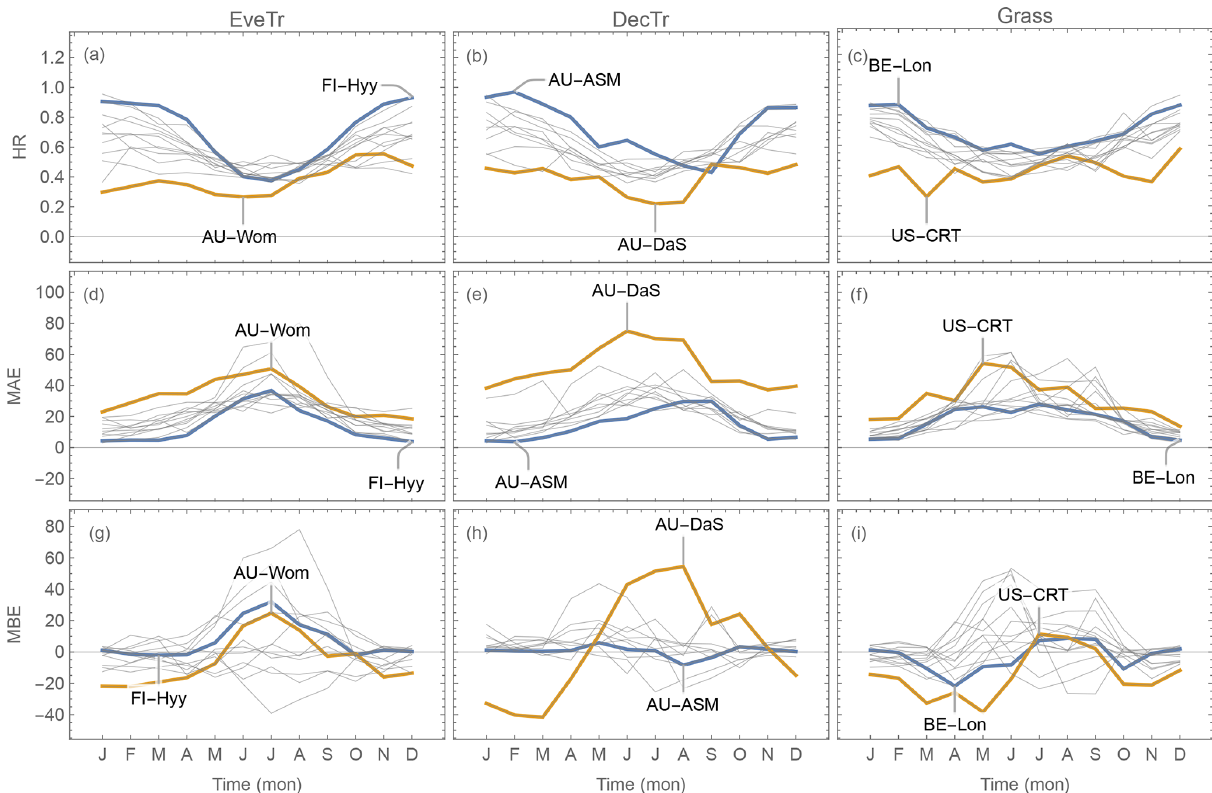
Figure 16. Variation in evaluation metrics (Sect. 5.2) based on 30 or 60min Q E data by month using the derived parameters based on FLUXNET2015 dataset (Tables C1–C3): (a–c) HR, (d–f) MAE, (g–i) MBE by sites grouped into three PFTs, ( a , d and g ) EveTr, ( b , e and h ) DecTr and ( c , f and i ) Grass with sites of best (blue) and poorest (orange) performance highlighted and others in grey (indicated by PS: see text and Eq. 35 for details). Note Southern Hemisphere sites are offset by 6 months (Sect. 5.1), so “general” seasons are consistent across